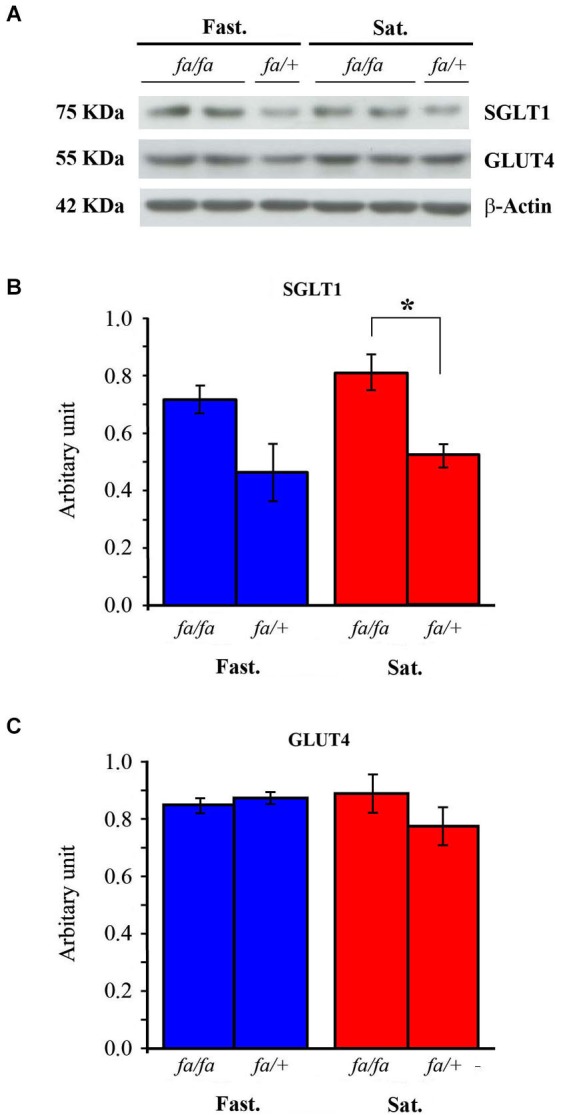
Western blot analysis of SGLT1 and GLUT4 in OB homogenates from fasted (Fast.) or satiated (Sat.) fa/fa and fa/+ Zucker rats. (A) A representative blot. The intensity of each band was measured by densitometry and normalized to the housekeeping protein actin, as a loading control. (B) SGLT1 levels were significantly greater in satiated fa/fa rats compared to satiated fa/+ rats. (C) GLUT4 levels were not significantly different significantly regardless of the rat genotype and the feeding state. * P < 0.05, mean ± S.E.M., n = 4/feeding state/genotype.